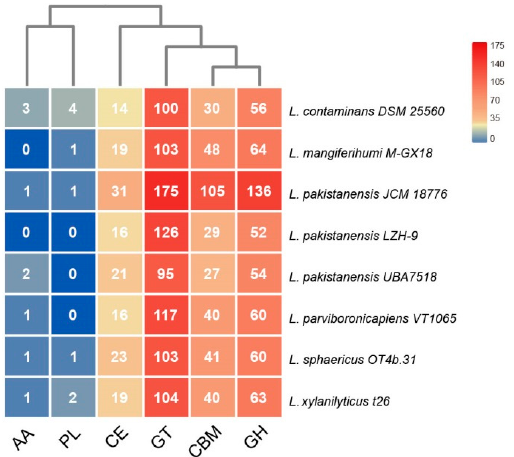
Figure 6. Heat map showing the distribution and numbers of genes encoding carbohydrate active enzymes (CAZymes) in eight different Lysinibacillus strains in this study. Abbreviations in the chart: AA, auxiliary activities; CBM, carbohydrate-binding molecules; CE, carbohydrate esterases; GH, glycoside hydrolases; GT, glycosyltransferases; PL, polysaccharide lyases.